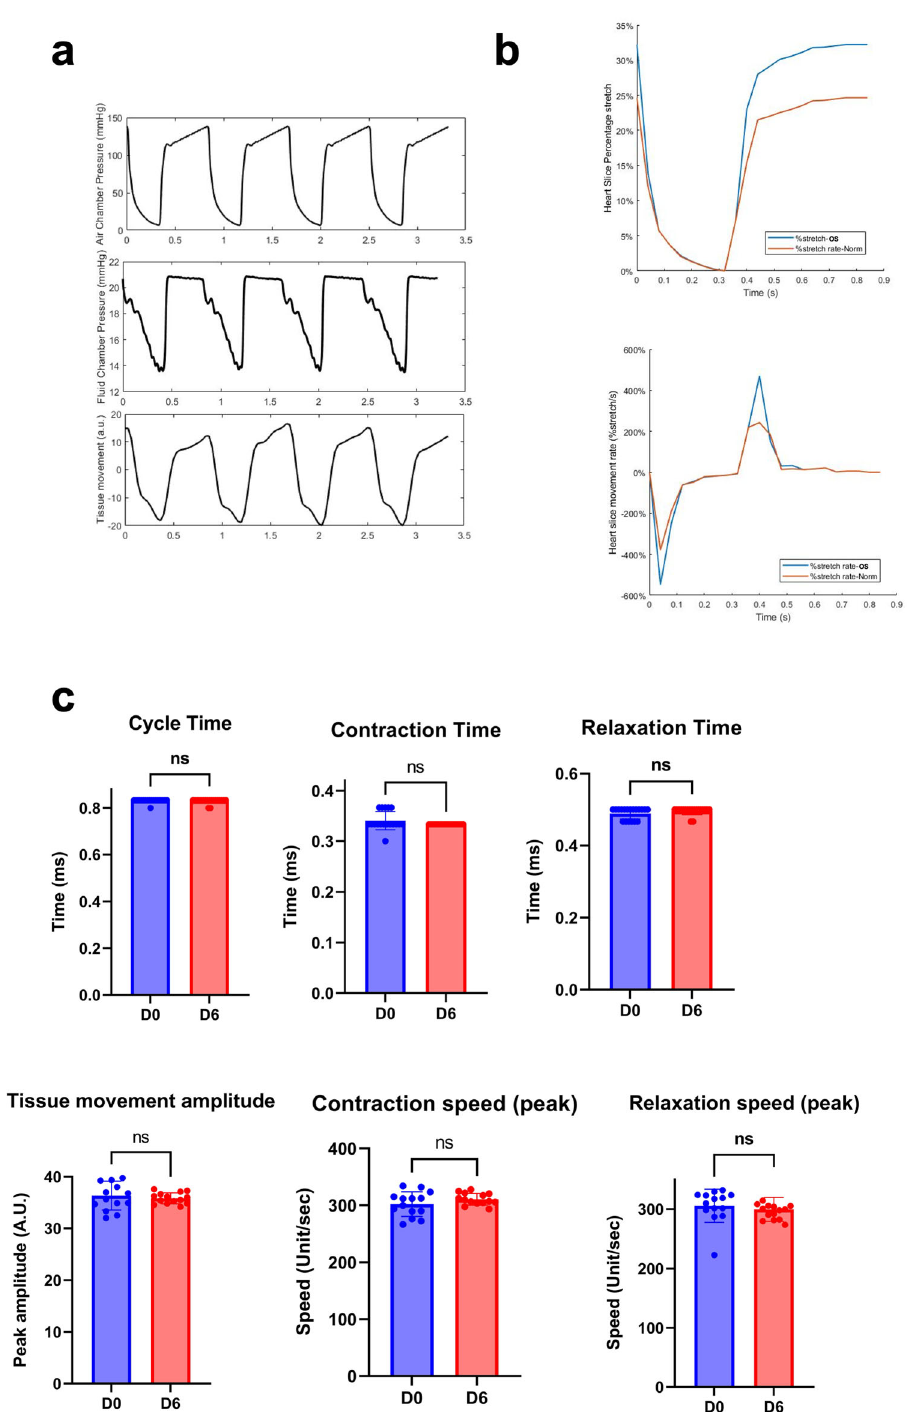
Fig. 6 Induction of pathological overstretching in heart slices cultured in CTCM device. a Representative traces of the air chamber pressure, fl uid chamber pressure, and tissue movement measurements veri fi ed that the air chamber pressure changes the fl uid chamber pressure, which induces a corresponding tissue slice movement. b Representative traces of the percent stretch and stretch rate of normal stretch (orange) and overstretched (blue) tissue slices. c Bar graphs showing quanti fi cation of the cycle time ( n = 19 slices/group from different pigs), contraction time ( n = 18 – 19 slices/group from different pigs), relaxation time ( n = 19 slices/group from different pigs), tissue movement amplitude ( n = 14 slices/group from different pigs), peak contraction speed ( n = 14 slices/group from different pigs), and peak relaxation speeds ( n = 14 (D0), 15 (D6) slices/group from different pigs), Two-tailed Student t -tests revealed no signi fi cant difference in any of the parameters, demonstrating that these parameters remained consistent over 6 days of overstretching culture. Error bars are representative of the Mean ±